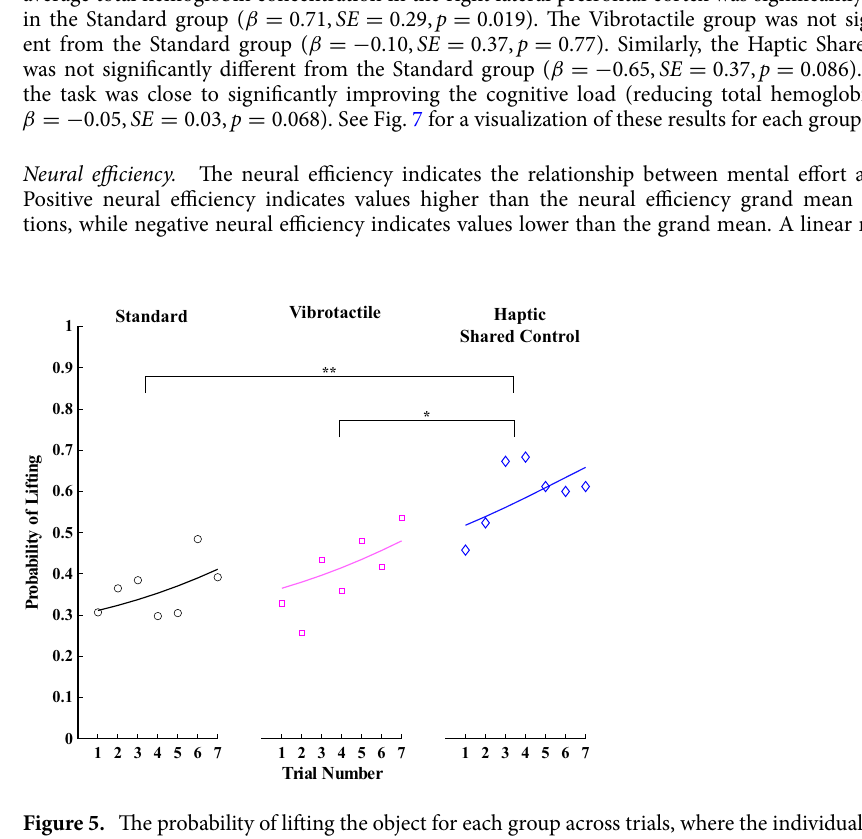
Figure 5. The probability of lifting the object for each group across trials, where the individual data points represent the average for each trial (for all participants in each group), and the solid lines indicate the model’s prediction. * indicates p < 0.05 , ** indicates p < 0.01 , and *** indicates p < 0.001